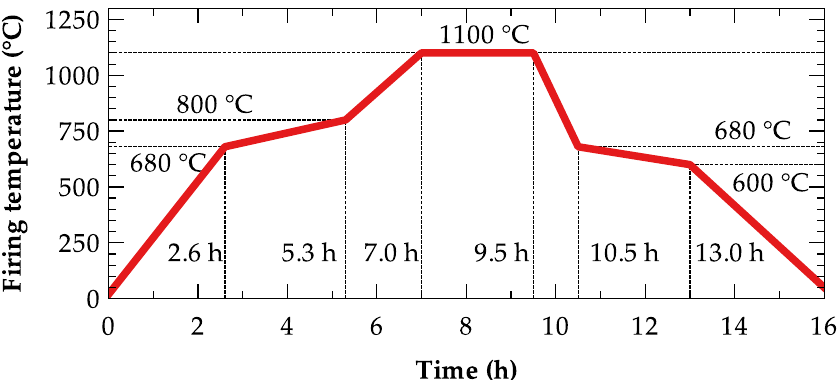
Figure 7. Optimal firing schedule according to Ferrer et al. [33].